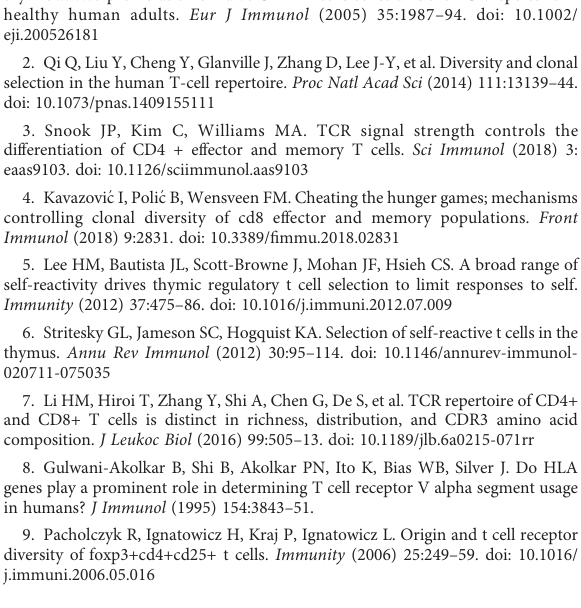
valuesinB.Meancosinevaluesfor a chainsequencesinC.ErrorbarsareSEM. ComparingeachrepertoiretoyoungnaïveinCD4+,CD8+andCD4+Tregin youngoradult mice(reddots=youngmice, bluedots =adultmice). SUPPLEMENTARY FIGURE 5.2 TCRV b genesimilarityfromcontrol2repertoiresplottedagainstCDR3 b AAtop tripletsimilaritydistribution,comparingeachrepertoiretoyoungnaiveinCD4 +, CD8+ and CD4+ Treg in young and adult mice (red and blue dots). Each point is the mean cosine score, and the error bars are SEM. SUPPLEMENTARY FIGURE 6.1 (A) Cosinesimilarity indexofTRBV genes,CDR3 b NT,andtopCDR3 b AA3- mers (top 350) motifs calculated between tissues and individuals. Colored dots re fl ect the mice groups (red = young, blue = adult, green/purple = mice after 8 and 40 days of acute LCMV infection, respectively). Horizontal black lines show the mean. The CD4+ and CD8+ naïve repertoires were subsampled as described in detail in Methods. The subsampling was repeated 100 times, and the mean values of each cosine similarity metric were calculated for TRBV genes, CDR3 b NT, and top CDR3 b AA triplets (350) motif distributions. (B-C) TCRV gene distribution similarity plotted against CDRAA top triplet similarity distribution in young vs. LCMV infected mice. The similarity between each repertoire and the young naïve in CD4+ and CD8+ repertoires to day 8or40 postLCMVinfection(green orpurple dots,respectively). The b chain sequences of all pair cosine values in B. Mean cosine values for a chain sequences in C. Error bars are SEM. SUPPLEMENTARY FIGURE 6.2 Increased convergent recombination levels in CD8+ splenic effector cells with age and LCMV infection. Each point represents the number of CDR3NT_VJ which encodes for the same CDR3AA b sequence (convergent recombination or coding-degeneracy) versus the frequency levels in young, adult, and mice after 8 days of LCMV infection (red or blue or green dots